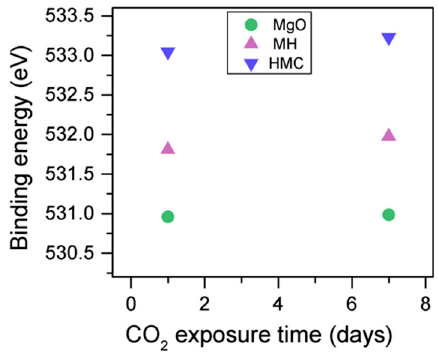
Figure 14. O1s BE for samples exposed to 10% CO 2 for one and seven days.